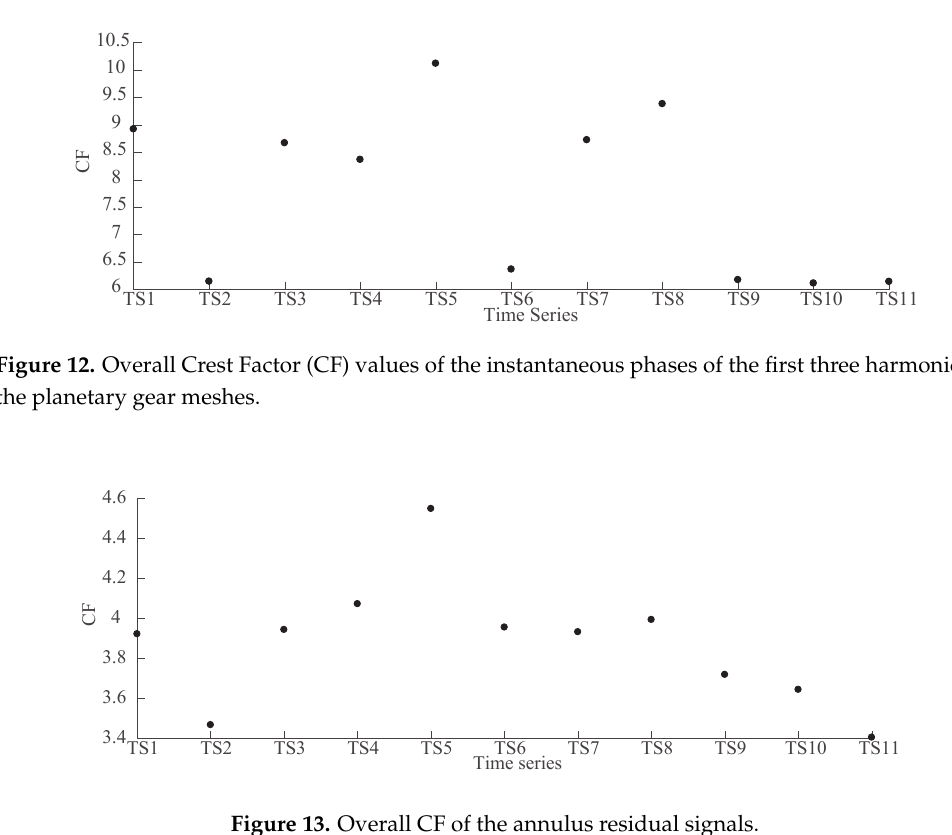
Figure 13. Overall CF of the annulus residual